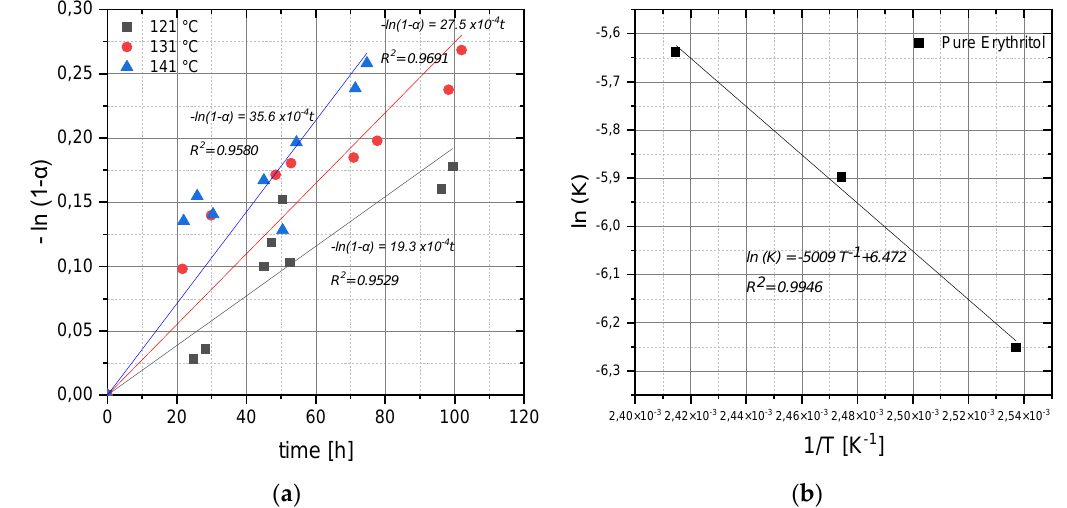
Figure 5. ( a ) Plot of degradation of latent heat −ln(1− α ) versus time t for pure erythritol under air at three different temperatures. Data points were subjected to a least squares fitting. ( b ) Arrhenius plot for latent heat thermal degradation of pure erythritol under air. Data points were subjected to a least squares fitting.